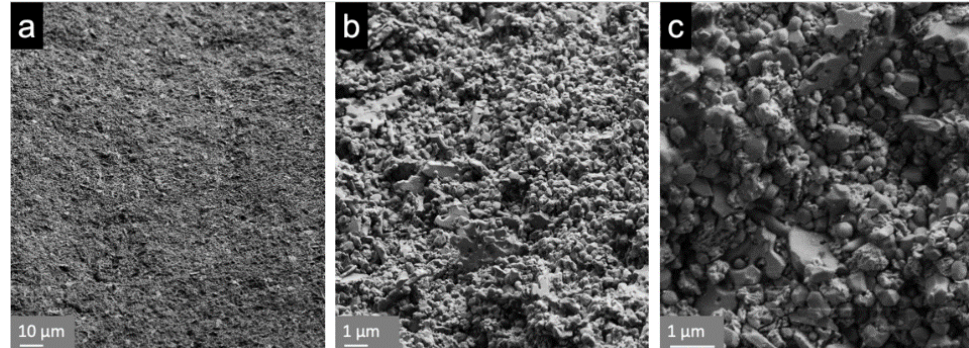
Figure 3. Scanning electron images (Supra 55VP, Zeiss, Oberkochen, Germany) of the blasted and etched endosseous surface of the implant prototypes with magnification of ( a ) ×500; ( b ) ×5000; ( c ) ×10,000.